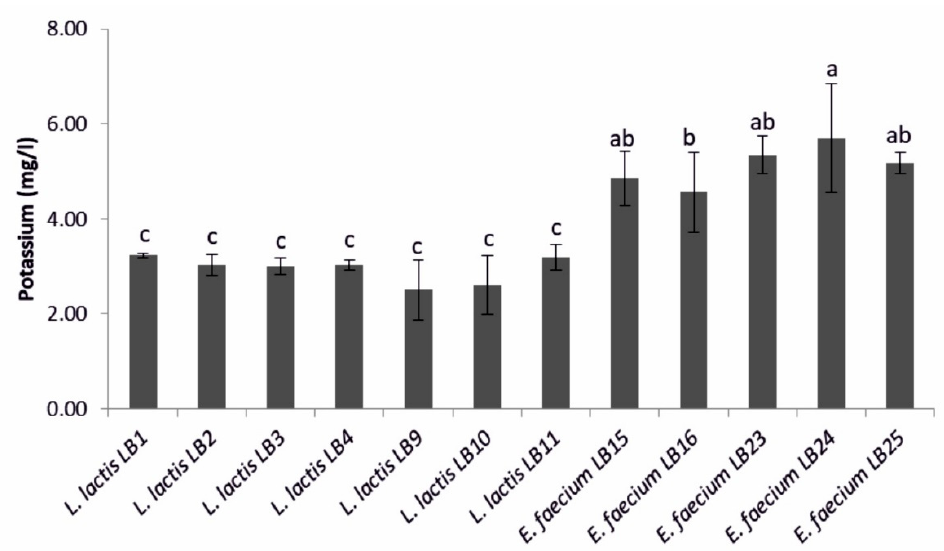
Figure 3. Amount of potassium solubilized by the lactic acid bacteria strains that showed a halo zone of potassium solubilization. Means (±SD) followed by the similar letter(s) are not significantly different at the 5% probability level (LSD test).